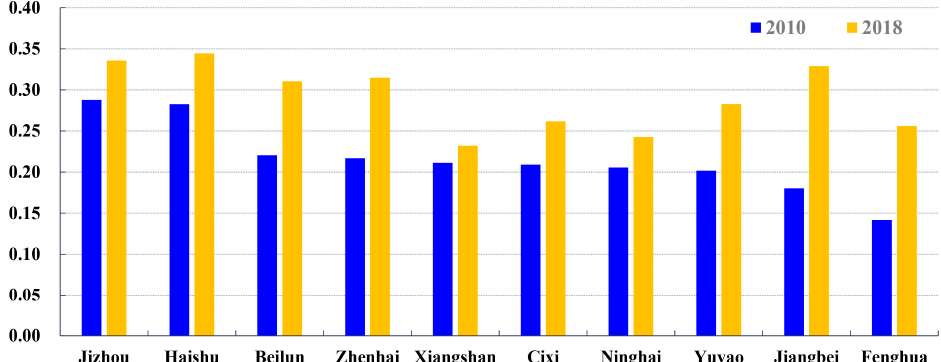
Figure 4. Sustainable development evaluation of PLES in Ningbo for ( a ) 2010 and ( b )